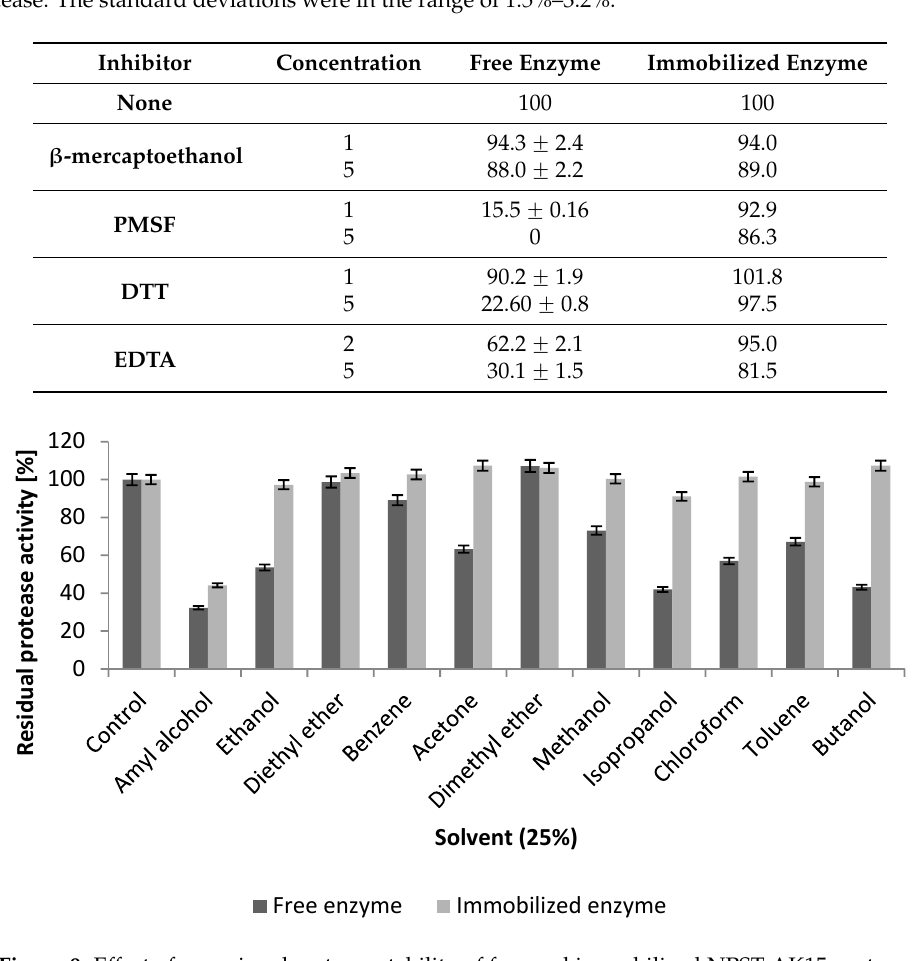
Figure 9. Effect of organic solvents on stability of free and immobilized NPST-AK15 protease.